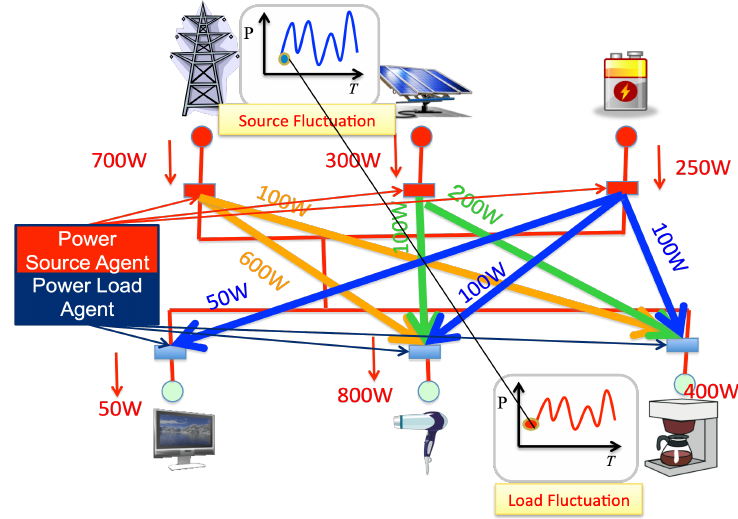
Figure 2. Representation of power sources, power loads, and connections between them.